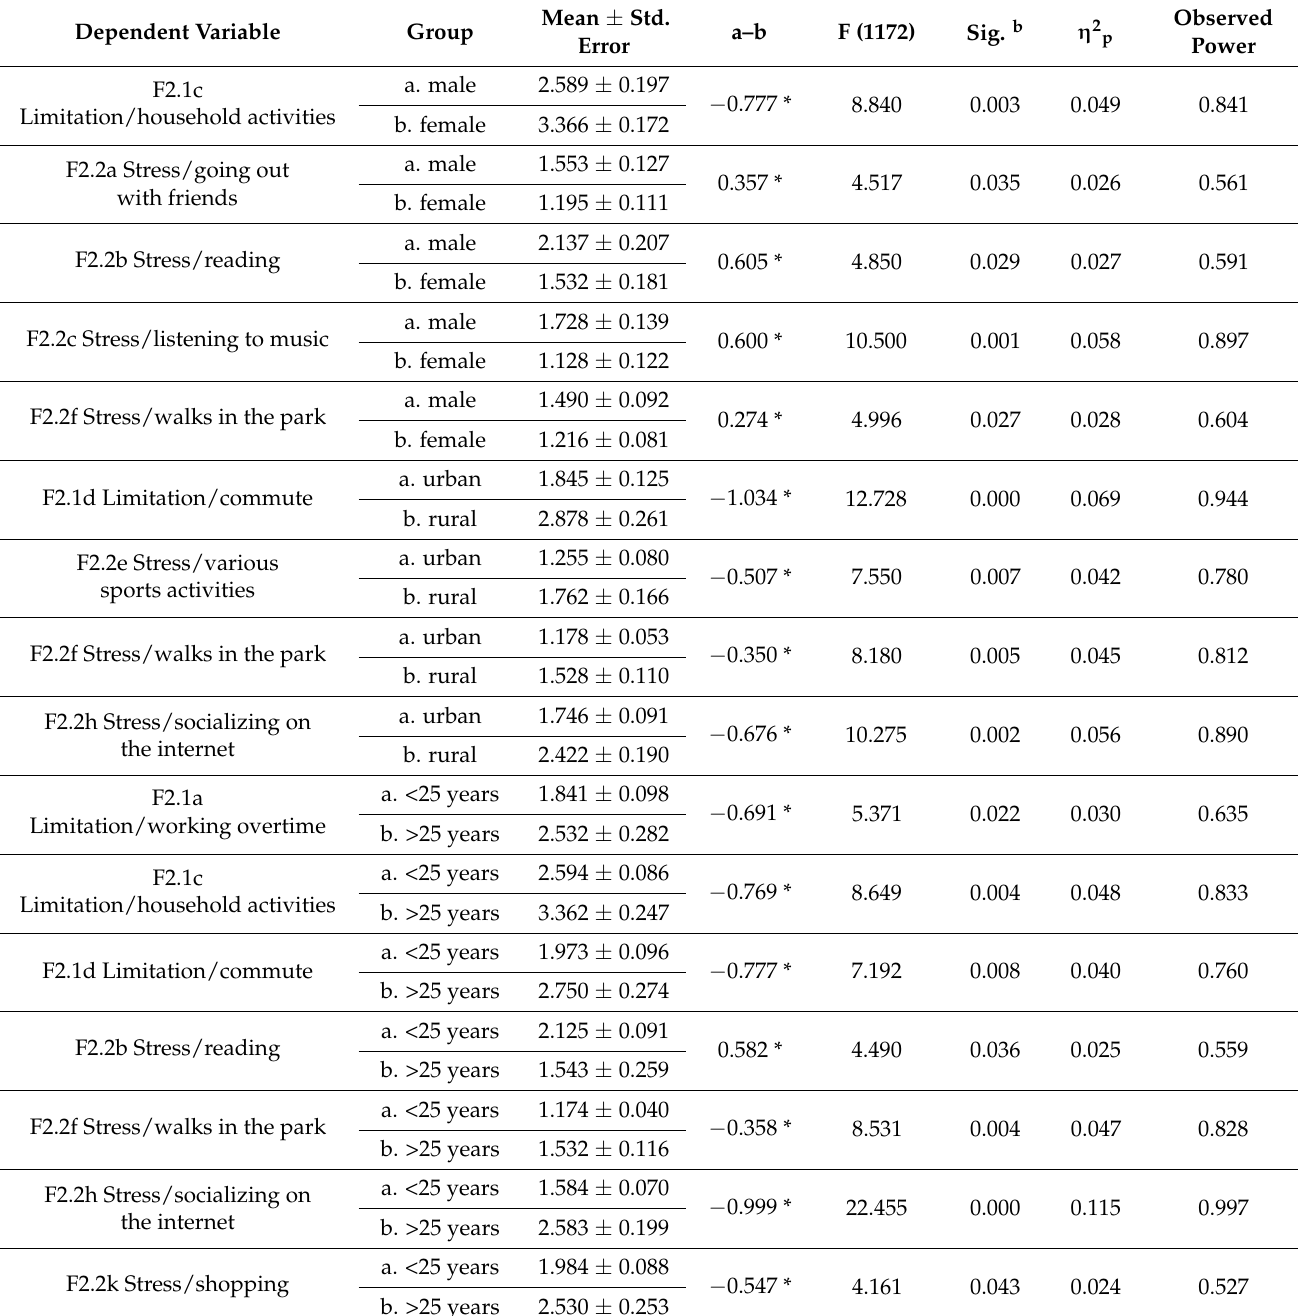
Table 5. The results of univariate tests/ANOVA and the comparison in pairs of the average values at the level of the items for factor 2/leisure limiting